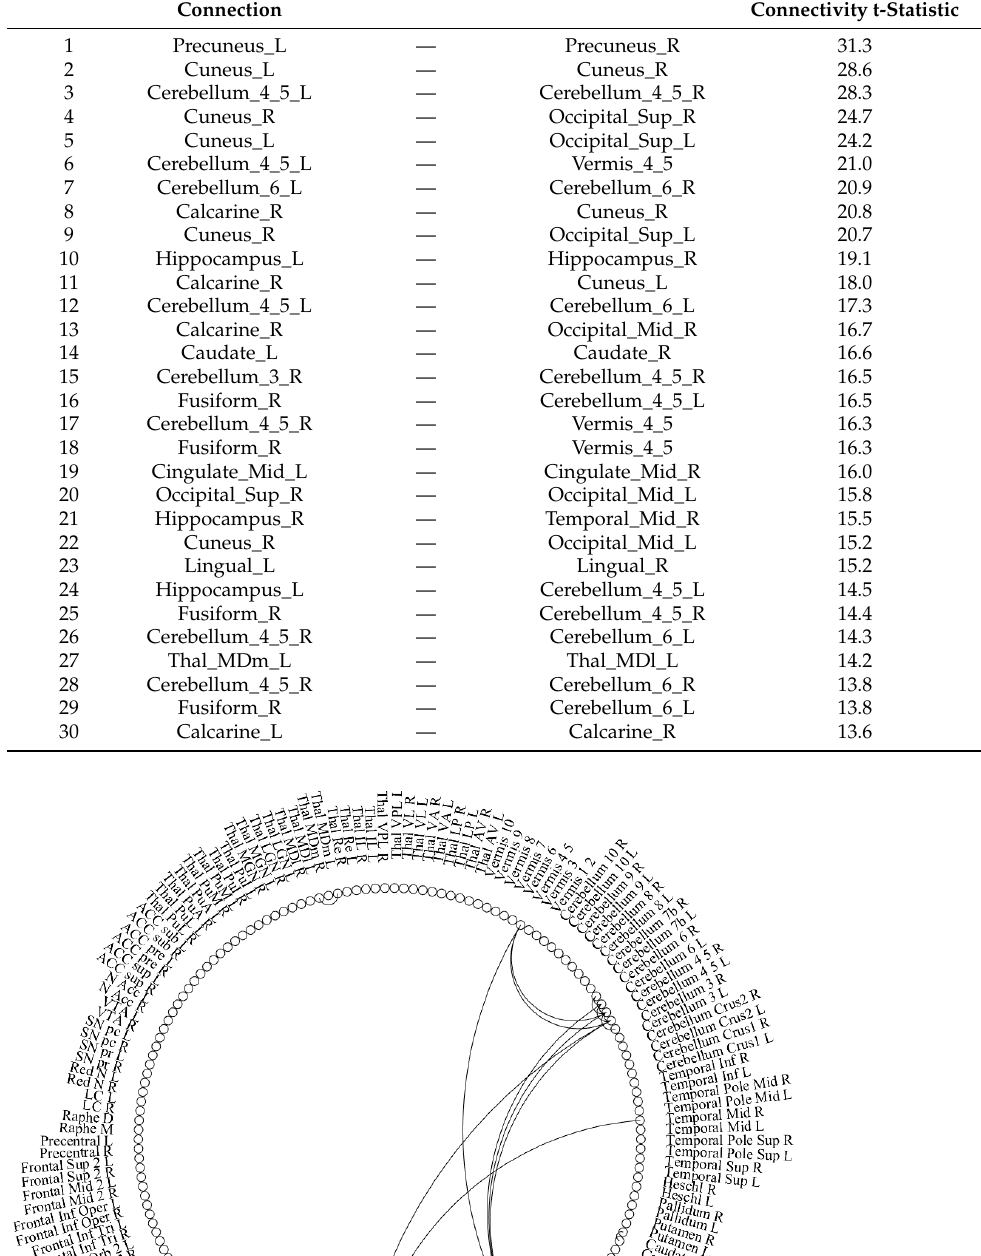
Table 2. The top 30 significant connections were stronger in the control group compared to the depression group.